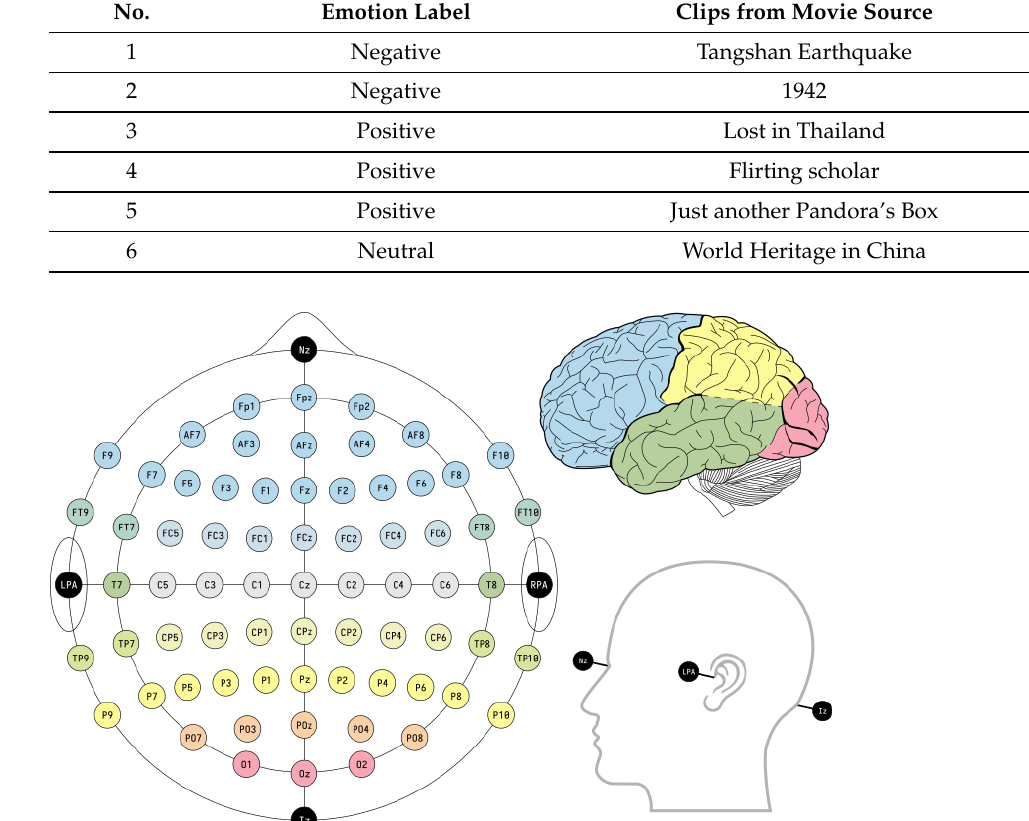
Figure 5. The placement chart of the International 10–20 System and allocation of all 62